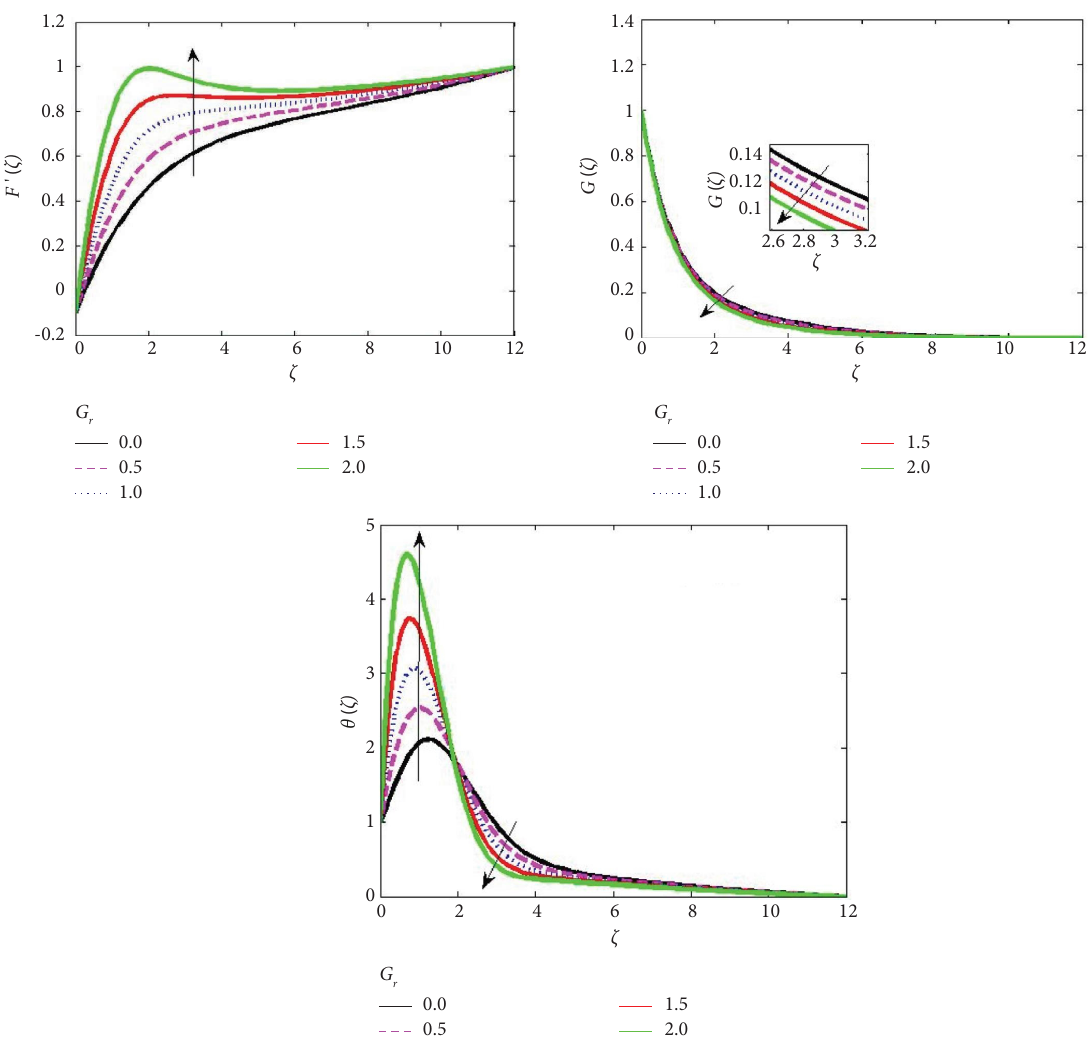
Figure 6: Efect of buoyancy ratio constant on the velocity, azimuthal velocity, and temperature